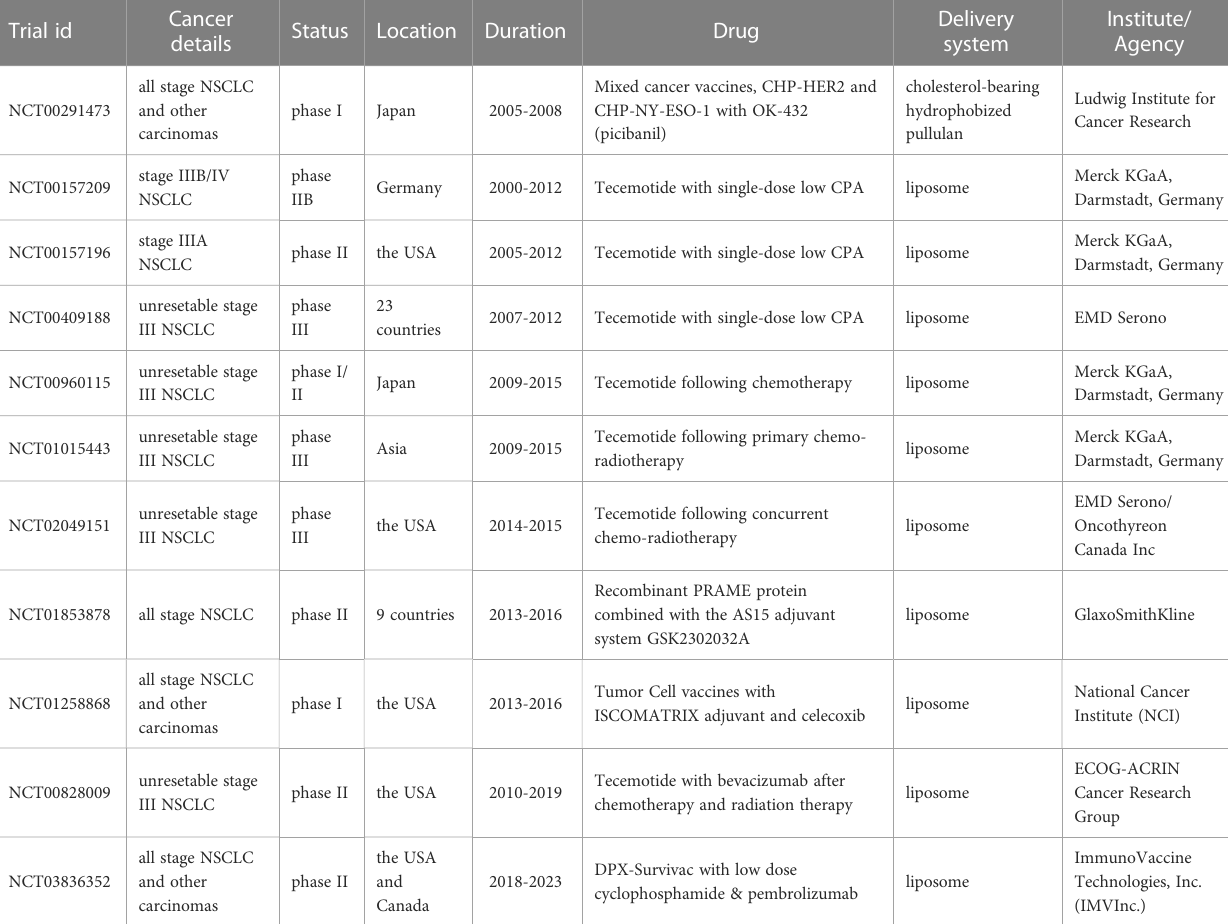
TABLE 2 Key clinical trials investigating ef fi cacy and safety of nanomaterials for lung cancer immunotherapy.